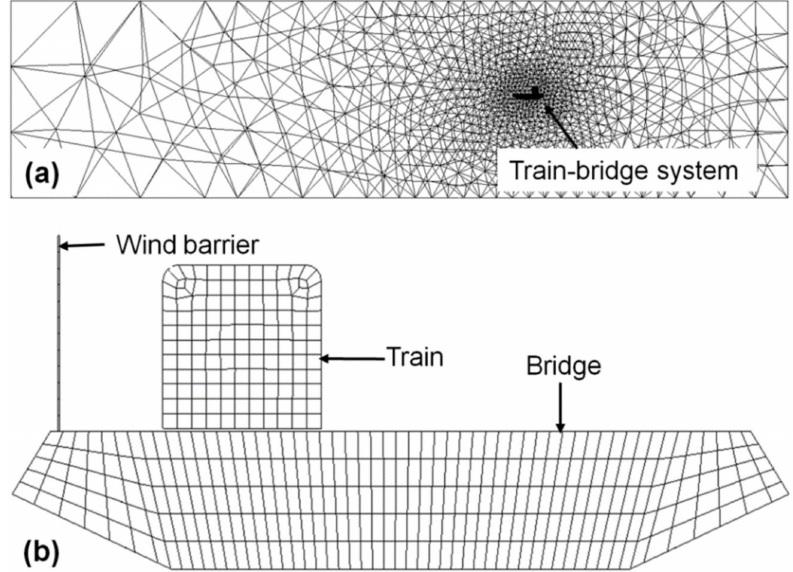
Figure 4. Meshing details for ( a ) the overall computational domain in the reduced-scale Fluent modelling and ( b ) the train–barrier–bridge system in the transient structural